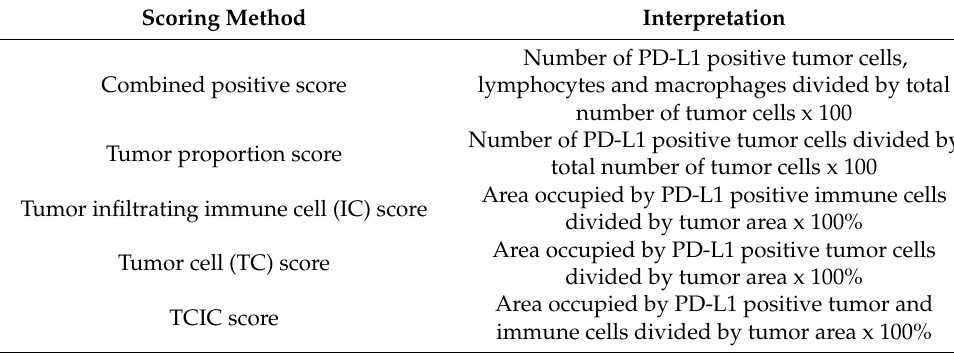
Table A1. Scoring methods for PD-L1